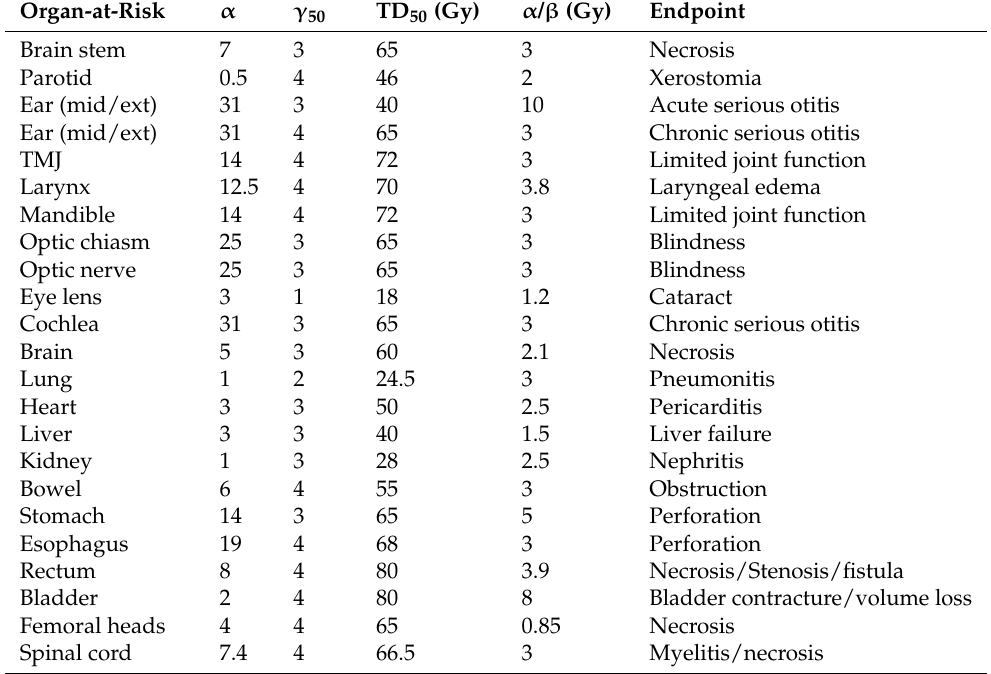
Table 2. Parameters introduced into the software for NTCP